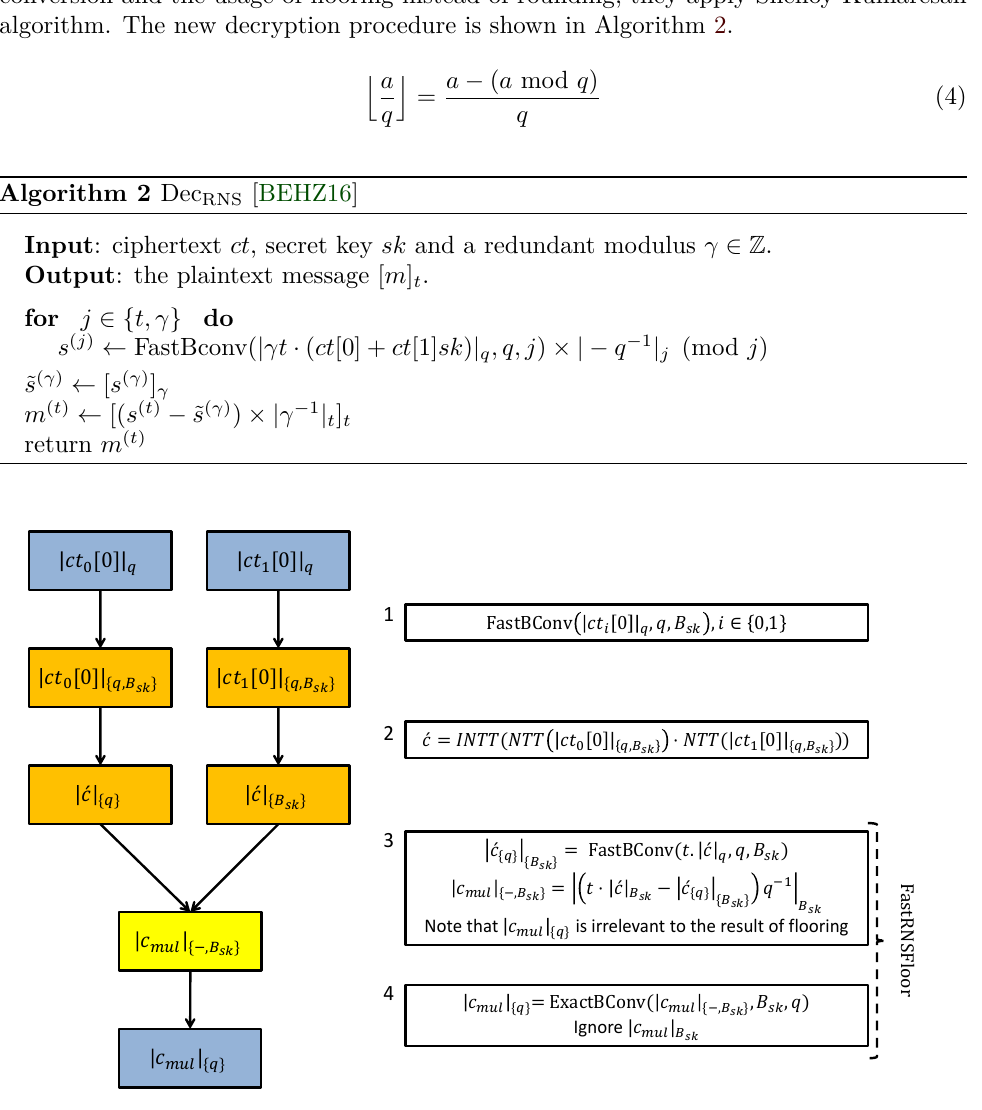
Figure 1: Flow diagram of computing divide-and-round in RNS